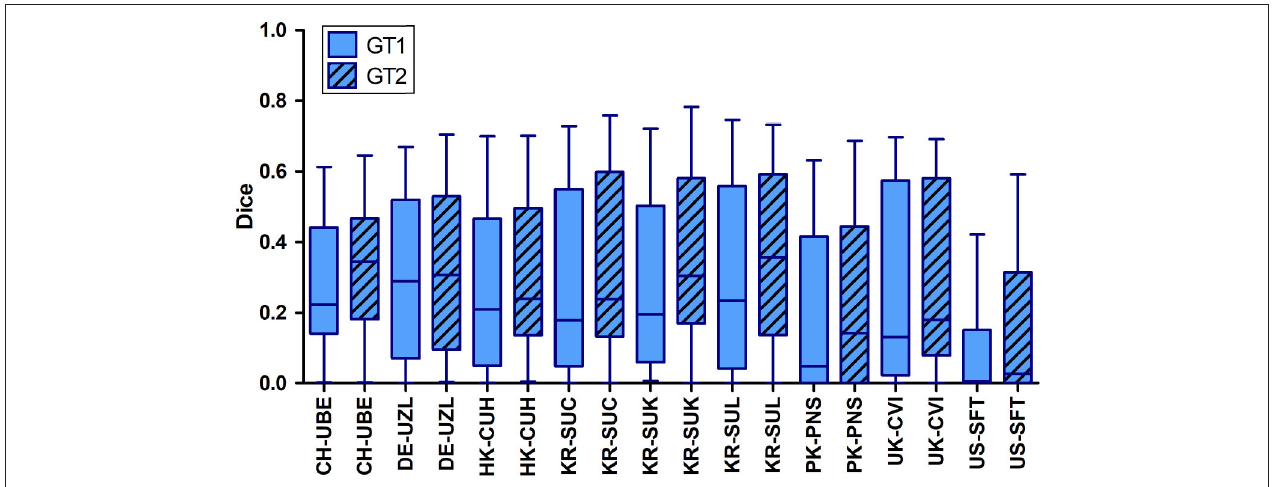
FIGURE 3 | Distribution of Dice scores computed between the automatic lesion predictions and both groundtruths (GT1 and GT2) individually for ISLES 2016. For all teams the Dice scores computed with respect to rater 1 were significantly lower than those calculated with respect to the 2nd groundtruth (GT2).